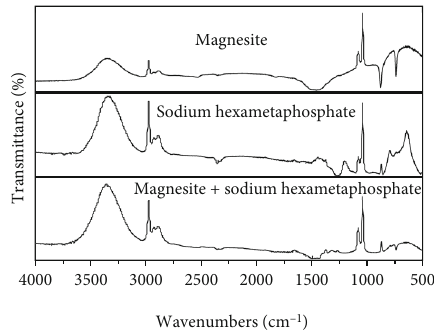
Figure 12: FTIR spectra of sodium hexametaphosphate and magnesite.